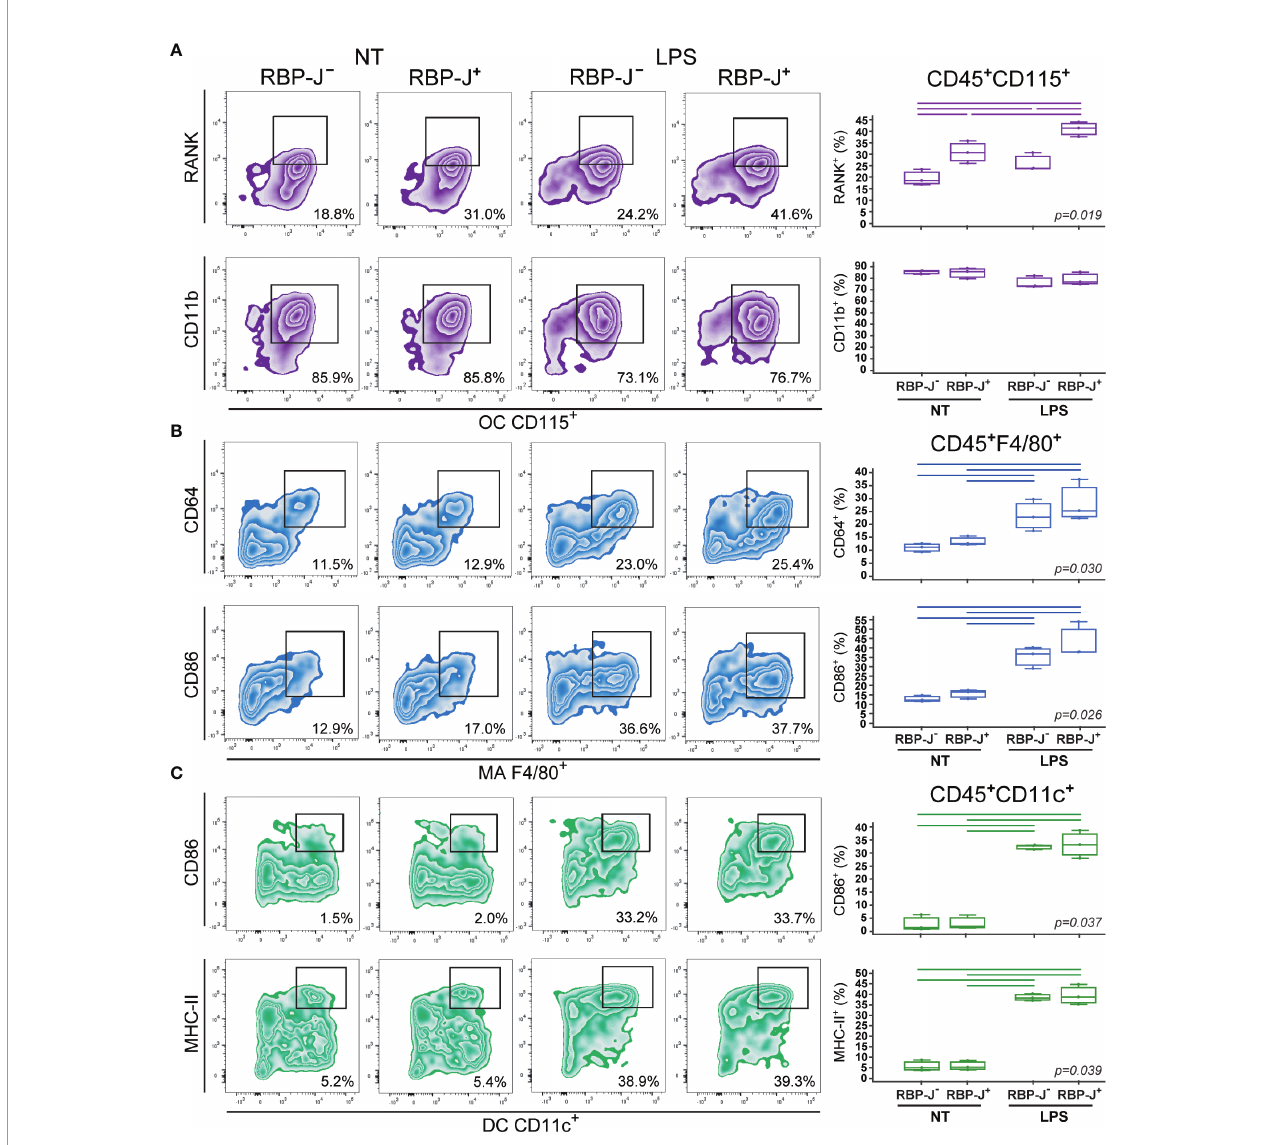
FIGURE 4 | Phenotype of osteoclasts (OCs), macrophages (MAs) and dendritic cells (DCs) differentiated from the common trilineage progenitor (TLP) of CX3CR1CreERT2/ RBP-J mice. Bone marrow cells were fl ushed from hind limb long bones and the common TLPs were identi fi ed as CD45 + Ly6G − CD3 − B220 − NK1.1 − CD11b – /lo CD115 + cells using fl ow-cytometry. TLPs were sorted and plated under appropriate culture conditions. Differentiation of OCs was induced by receptor activator of nuclear factor k B ligand (RANKL) and macrophage colony-stimulating factor (M-CSF); MAs by M-CSF; DCs by interleukin 4 (IL-4) and granulocyte-macrophage colony-stimulating factor (GM-CSF). Cre-mediated recombination in Cre + (RBP-J + ) littermates was induced by the addition of 4-hydroxytamoxifen (4-OHT). Cre − (RBP-J − ) littermates treated with 4-OHT were used as controls. Lipopolysaccharides from E.coli (LPS) were added 12h before harvesting, to induce the in fl ammatory response; non-treated (NT) cells were used for comparison. Cells were harvested at culture day 2. (A) Expression of RANK and CD11b on CD115 + osteoclast-committed progenitors stimulated by LPS. Representative dot plots showing RANK + CD115 + and CD11b + CD115 + subpopulations. (B) Expression of CD64 and CD86 on F4/80 + macrophage-committed progenitors stimulated by LPS. Representative dot plots showing CD64 + F4/80 + and CD86 + F4/80 + subpopulations. (C) Expression of CD86 and MHCII on CD11c + dendritic cell-committed progenitors stimulated by LPS. Representative dot plots showing CD86 + CD11c + and MHCII + CD11c + subpopulations. (A – C , right ) Individual values of biological triplicates are presented; horizontal lines represent the median, boxes represent the interquartile range (IQR), whiskers represent 1.5 times the IQR. Statistically signi fi cant difference was determined at p<0.05, Kruskal – Wallis test followed by Conover test for group-to-group comparisons (lines denote signi fi cant difference between